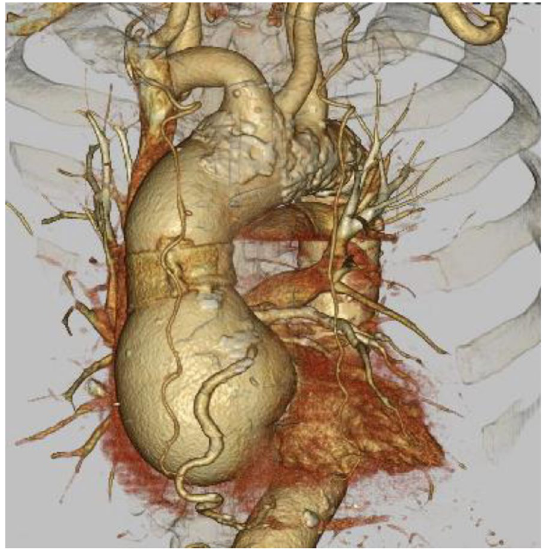
Fig. 1 Preoperative three-dimensional computed tomography. The sinus of Valsalva was 62 mm in